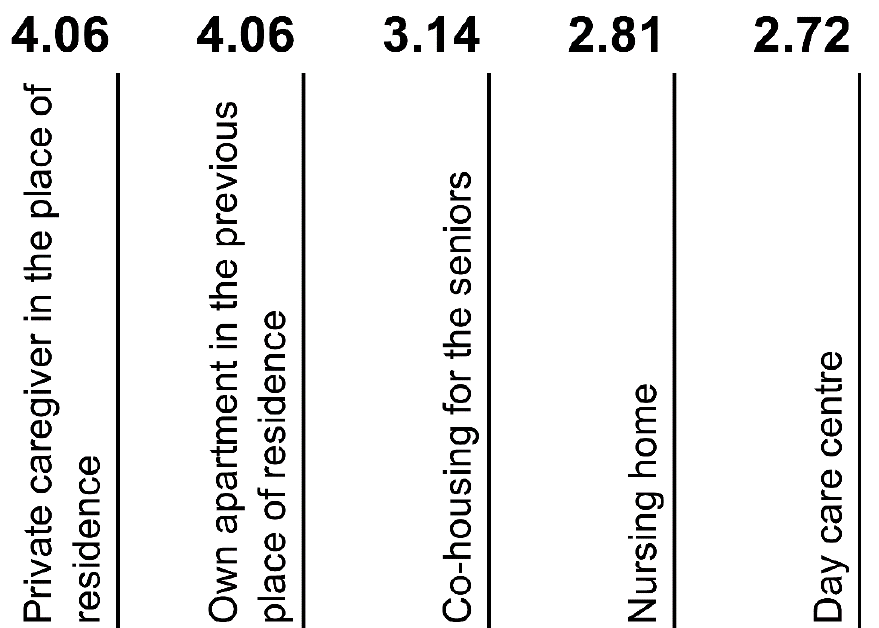
Figure 5. Evaluation of possible forms of housing for the elderly.